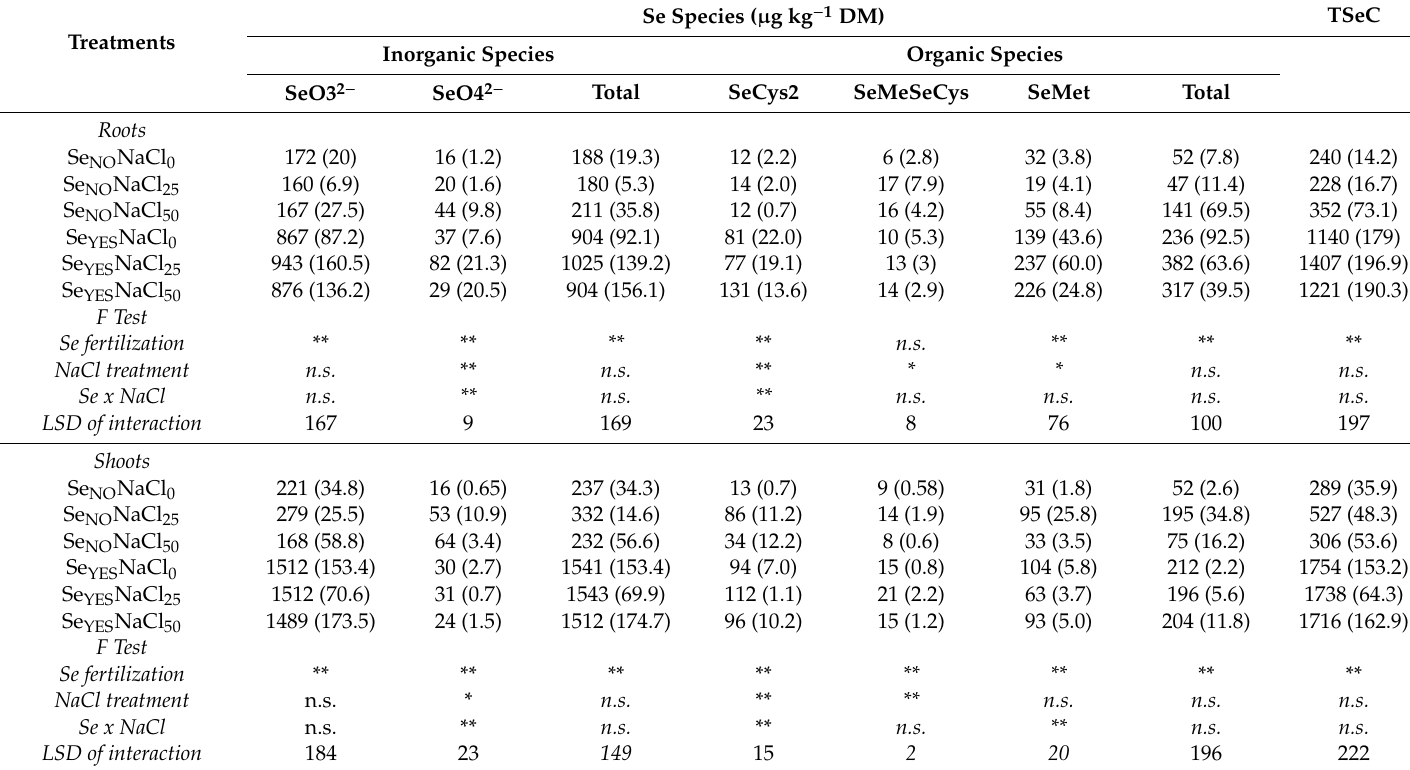
Table 2. Inorganic and organic Se species and total Se concentration (TSeC) in shoots and roots of maize sprouts obtained at 0, 25, or 50 mM NaCl (i.e., NaCl 0 , NaCl 25 , and NaCl 50 , respectively) from grains produced without or with Se fertilization (i.e., Se NO and Se YES , respectively).